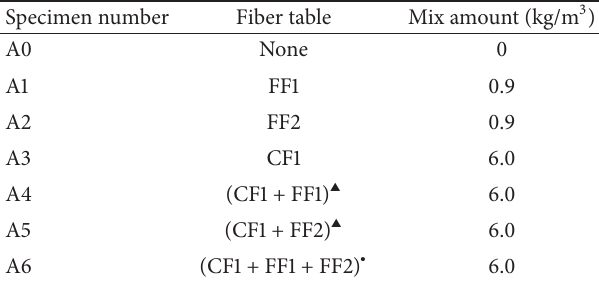
Table 2: The amount of polypropylene fiber (kg/m 3 ) for different specimens.